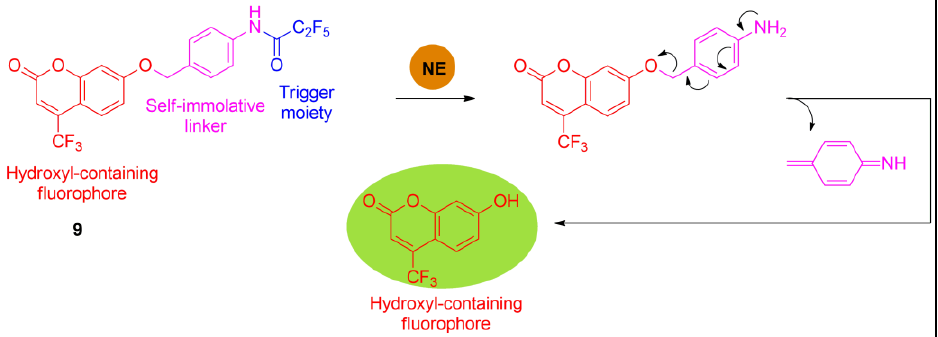
Figure 9. Construction of NE probe 9 containing hydroxyl fluorophores and self-immolation group. Adapted with permission from [54]. Copyright (2023)